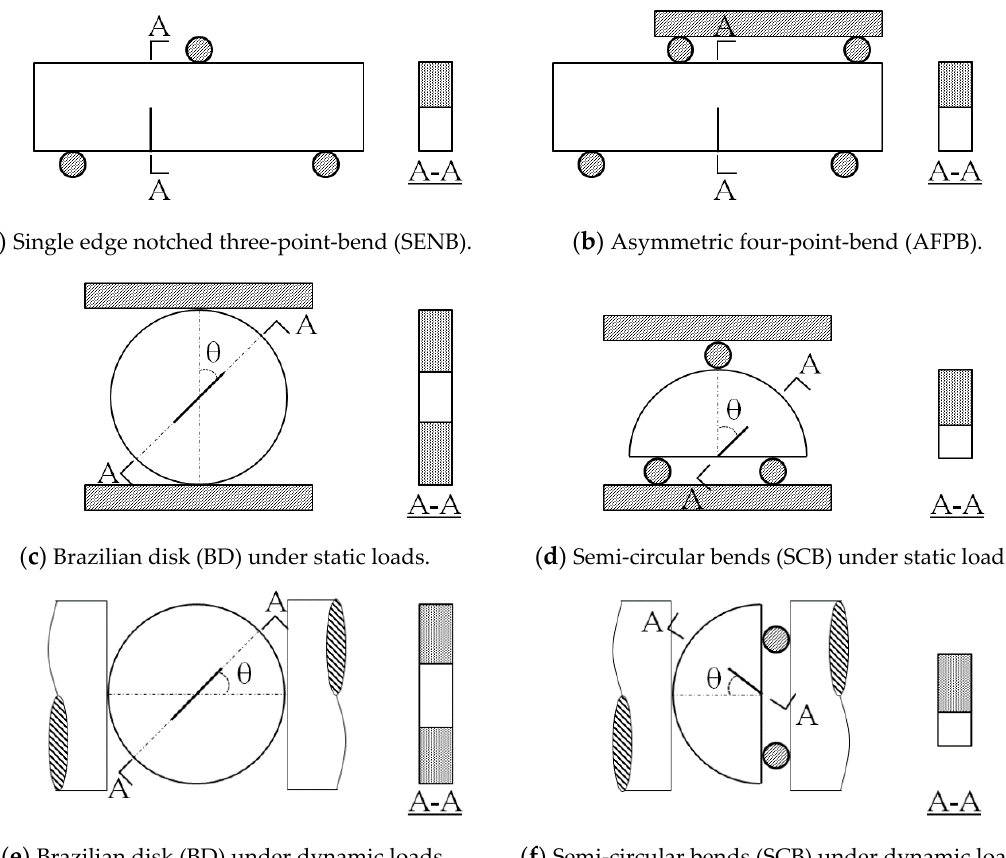
Figure 1. Different specimens in the mixed-mode fracture testing. ( a ) Single edge notched three-point-bend (SENB). ( b ) Asymmetric four-point-bend (AFPB). ( c ) Brazilian disk (BD) under static loads. ( d ) Semi-circular bends (SCB) under static loads. ( e ) Brazilian disk (BD) under dynamic loads. ( f ) Semi-circular bends (SCB) under dynamic